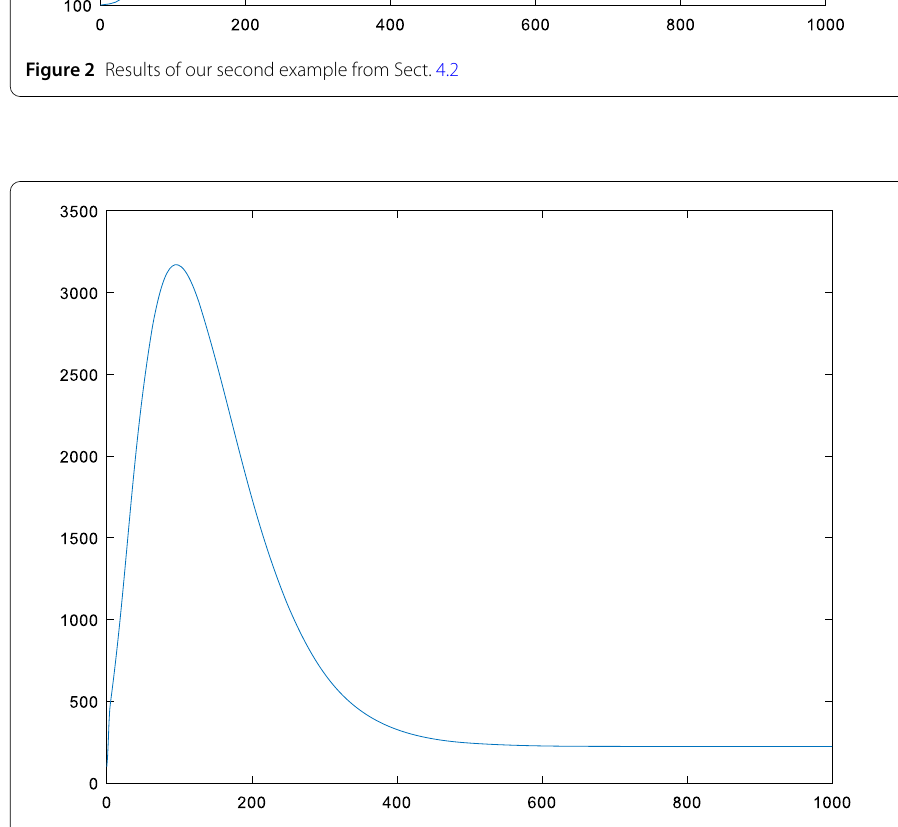
Figure 3 Results of our third example from Sect.